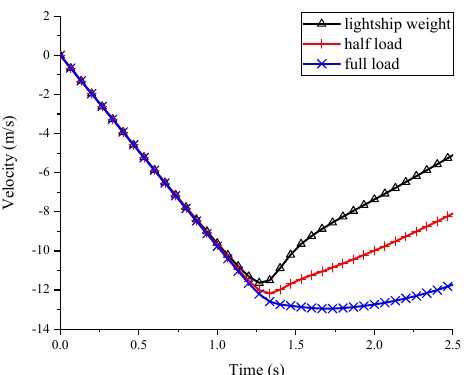
Figure 21. Comparison of the velocity of the stern among the three loading conditions.